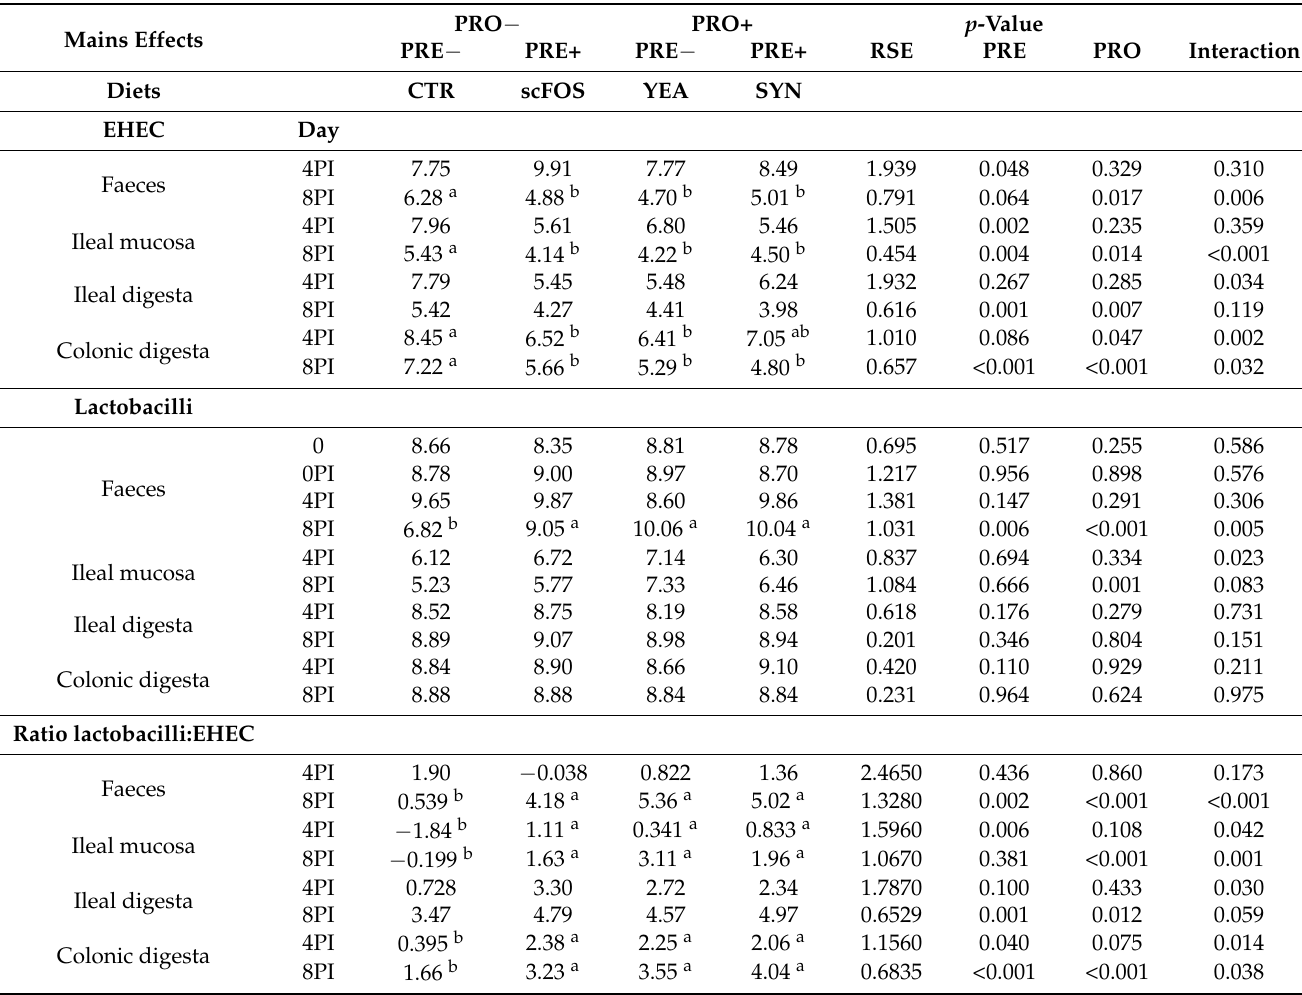
Table 4. Plate counts (log CFU/g) of EHEC (chromogenic media), lactobacilli (selective MRS medium), and ratio of lactobacilli/EHEC (as difference of logarithms) in fecal, ileal mucosa scrapings, and ileum and colon digesta samples. Values are given for day 4 and 8 post